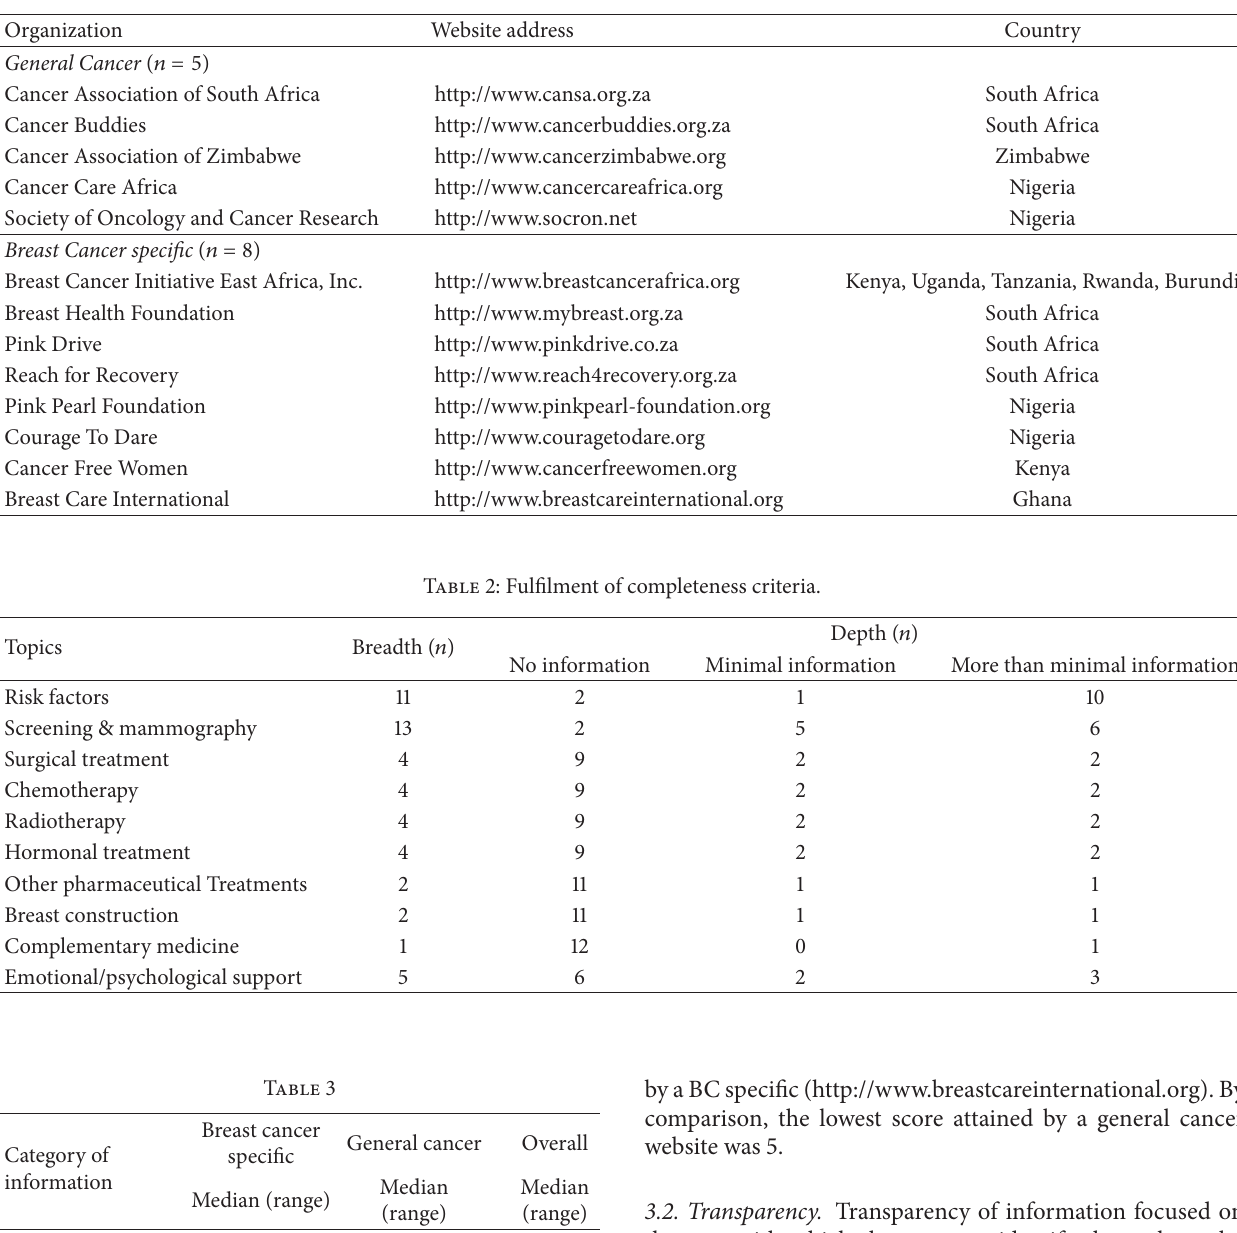
Table 1: Characteristics of included websites.